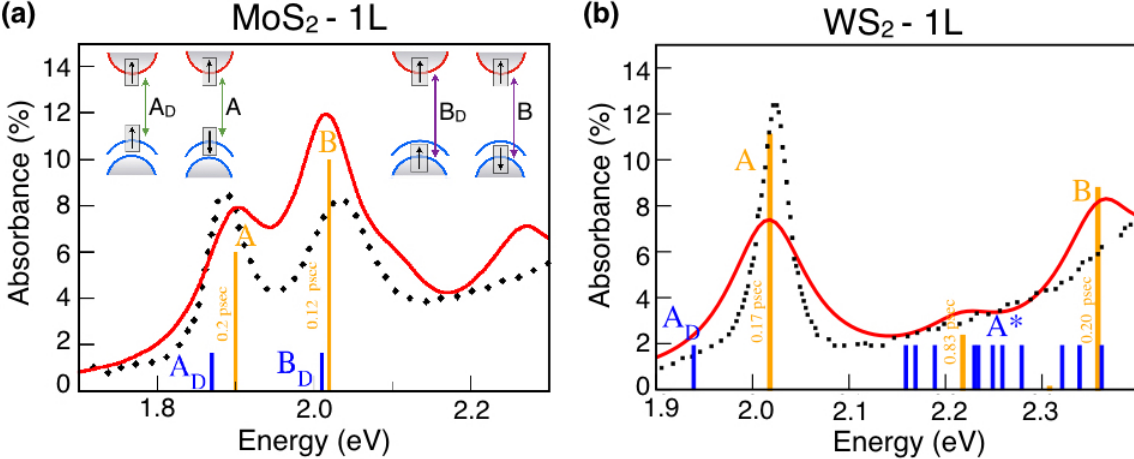
Figure 4: Optical absorption in monolayer MoS 2 (a) and monolayer WS 2 (b) . Shown are the experimental (black dots) and computed (red lines) absorbance spectra. The bright A and B excitons are shown in yellow, together with their intrinsic 0 K radiative lifetimes obtained from the BSE (see Ref. [62]). The A D and B D dark excitons and the A* dark excitons in WS 2 are shown in blue. The inset in (a) shows the dipole-allowed and dipole-forbidden transitions at a given set of valleys (say, K + ). The transitions at K − (not shown) are the time-reversal of those shown here. The data are taken from Ref.